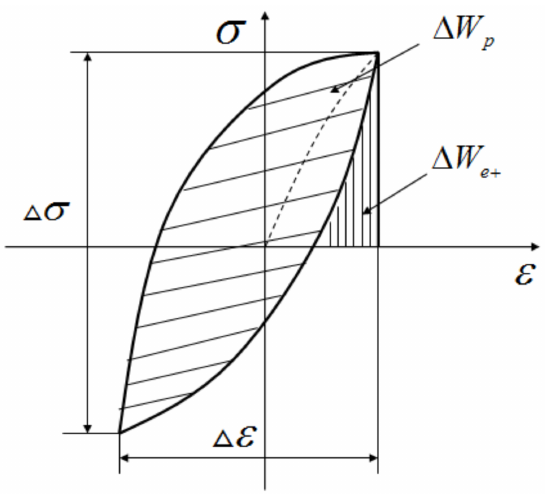
Figure 8. Calculation of elastic and plastic strain energy